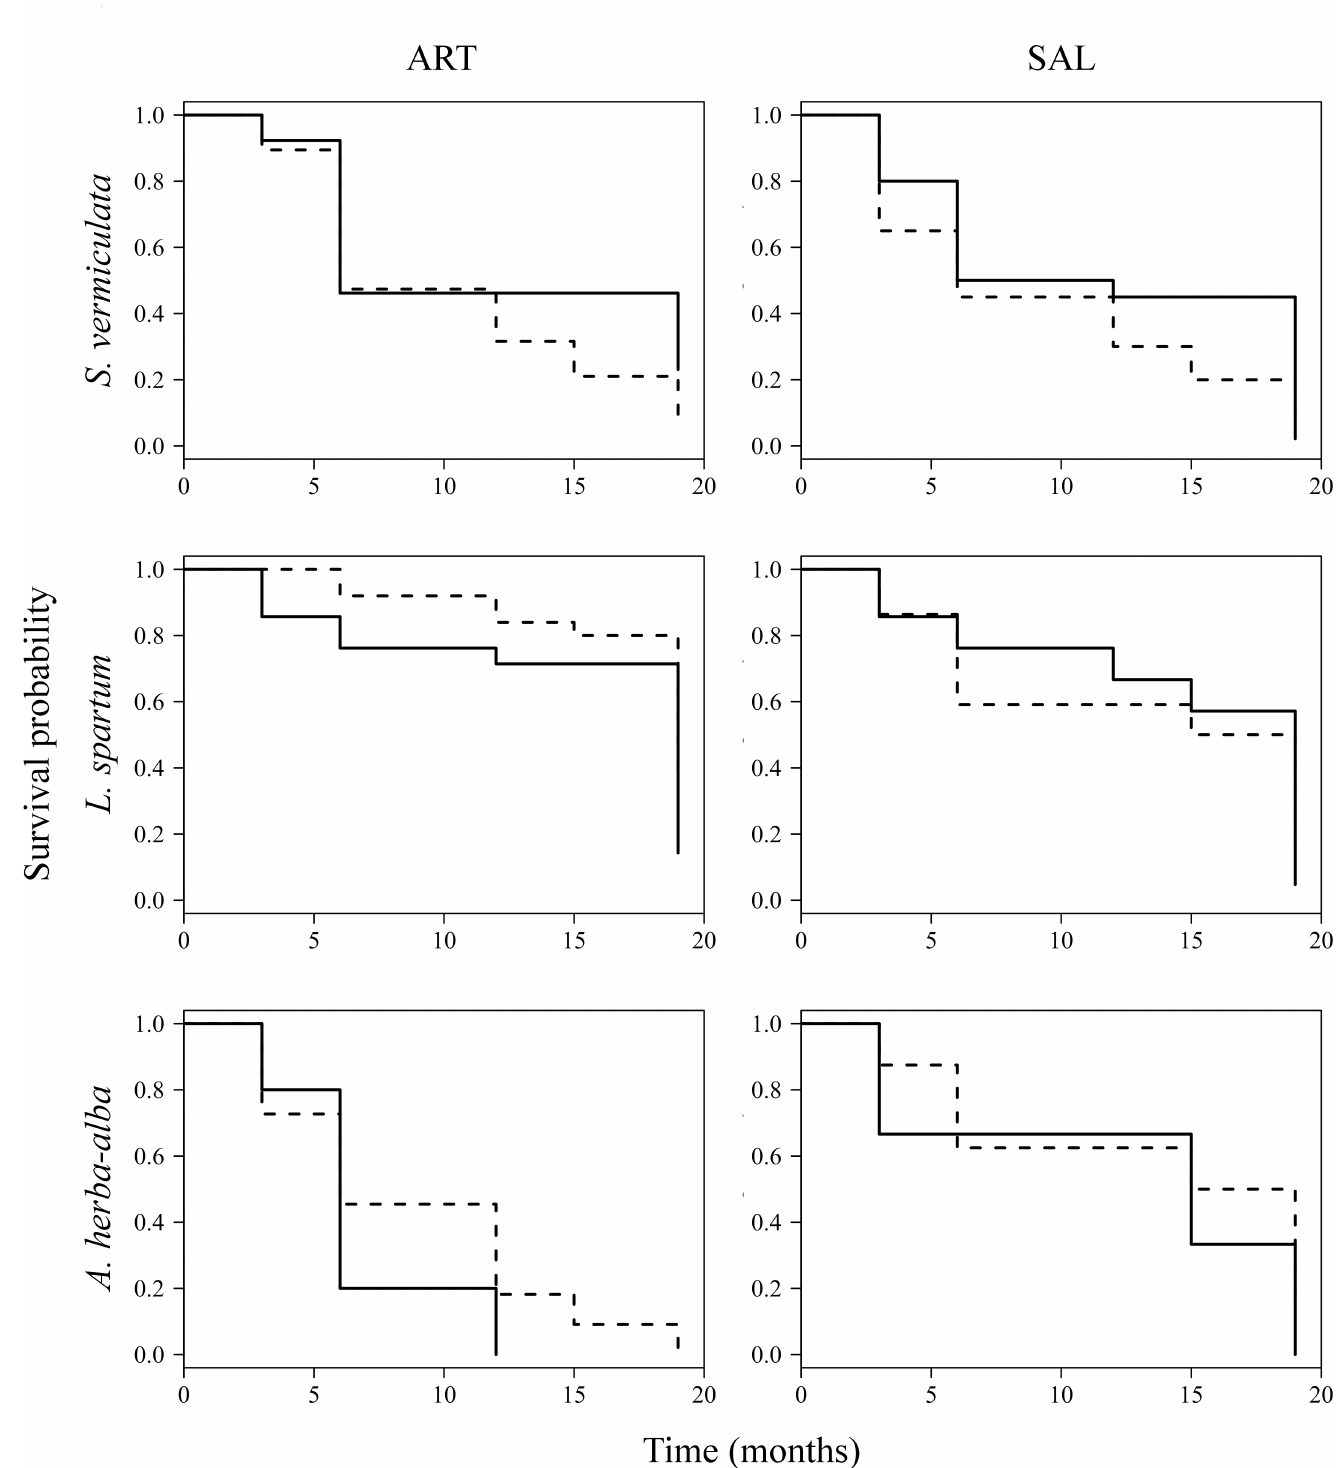
Fig 4. Seedling survival (Kaplan-Meier curves) of target species by treatment and shrub microsite. Dashed and solid lines represent germination of seeds sowed with and without the addition of AC respectively. ART, A . herba-alba ; SAL, S . vermiculata .